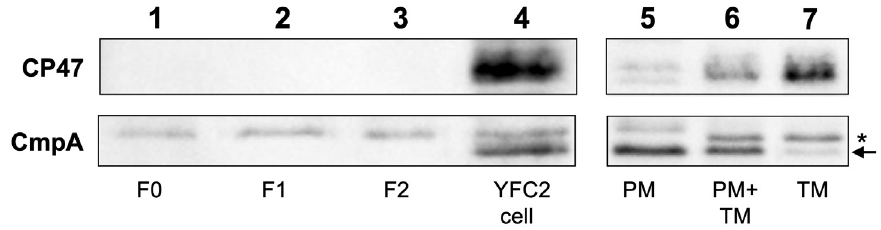
Figure 5. Western blotting analysis of Fractions 0, 1, and 2. Fractions 0 (lane 1), 1 (lane 2), 2 (lane 3), and a total extract of dark-grown YFC2 cells (lane 4). As controls of cross-reactivity of the antibodies, plasma (lane 5) and thylakoid (lane 7) membranes and a mixture of these membranes (lane 6) from dg5 (wild type) grown in the dark were also analyzed (0.4 µg of protein per lane). Antisera against CP47 and CmpA were used to detect thylakoid and plasma membrane-specific proteins, respectively. The CmpA signal is indicated by the arrow. * indicates a non-specific signal of the anti-CmpA antiserum.